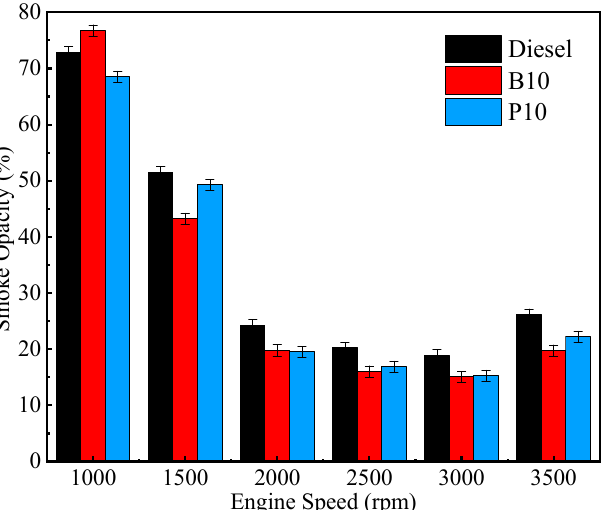
Figure 34. Smoke emission comparison of biodiesel blends and diesel at different engine speeds [258]. On the contrary, Arunkumar et al. [185] used castor biodiesel to investigate diesel engine performance and emission characteristics. The smoke emissions for different castor biodiesel addition ratios in Figure 35 indicate lower smoke generation for B20 at loading conditions due to better fuel–air mixing. However, as the ratio of biodiesel increases, due to the higher viscosity of castor oil, a localized poor fuel–air forms in the cylinder, pro ‐ ducing more smoke emissions than diesel. A similar trend was also observed by Bana ‐ purmath et al. [259] using Honge, Jatropha, and sesame oil methyl esters. They indicated that the heavier biodiesel molecular structure and higher viscosity, poor atomization, and the evaporation of biodiesel lead to higher smoke emissions.